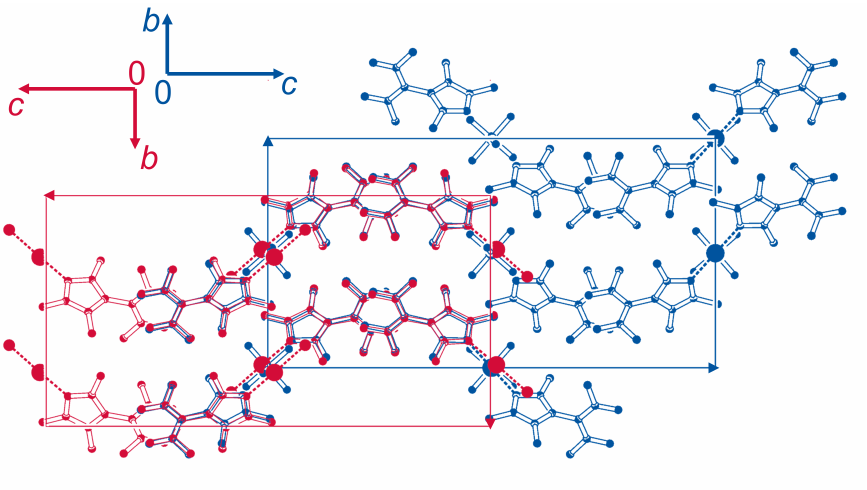
Figure 6. Overlay plot [33] of the unit cells of 2 (red) and 1 (blue) (hydrogen omitted), view along a